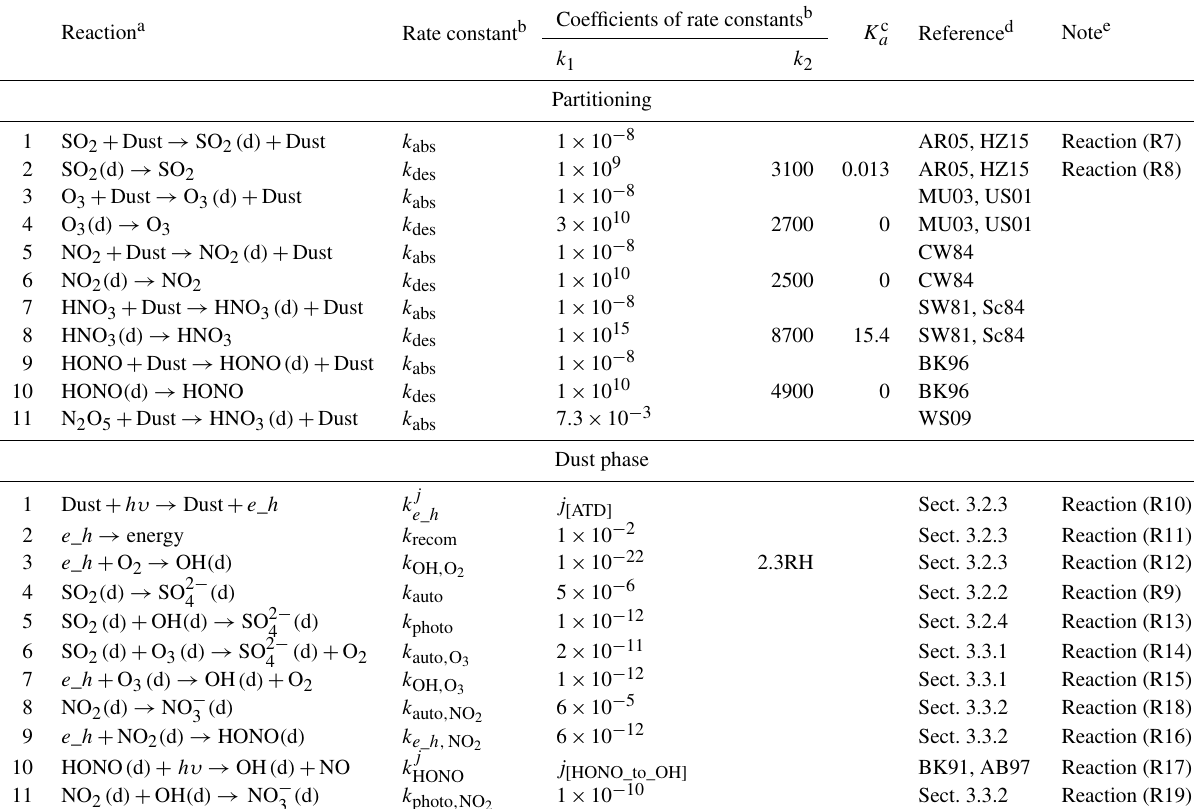
Table 3. Dust-phase heterogeneous reactions and their rate constants in the presence of ATD particles. Reaction a Rate constant